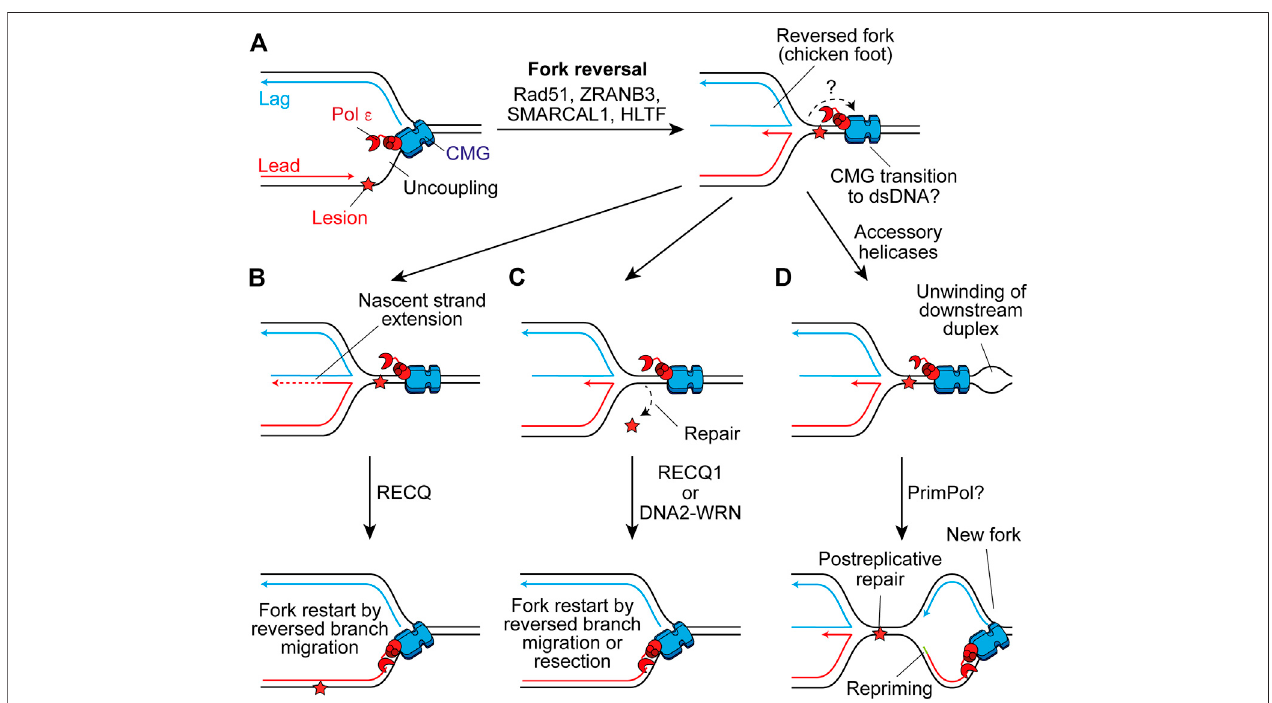
FIGURE6| Forkreversalmaymaintainorrestartreplisomeprogressionpastleading-strandimpediments. (A) Followinguncoupling,forkreversalcanbecatalysed by Rad51, ZRANB3, SMARCAL1, and HLTF to generate a four-way chicken foot structure in a process which is not currently well understood. The fate of CMG here is not clear, one possibility is that it transitions on to duplex DNA downstream of the lesion. (B) The nascent lagging strand could serve as a template for extension of the nascentleadingstrand.Subsequentreversedbranchmigration,catalysedbyRECQ1,maysupportforkrestartiftheextended3 ′ endofthenascentleadingstrand isrelocated downstreamofthe lesion.CMGmay thentransition backonto ssDNAtorestartcanonicalreplication. (C) Alternatively, forkreversal may placethelesion ina dsDNA context to permit repair, before resetting of the fork by RECQ1 or resection of nascent strands by DNA2-WRN. Again, CMG may transition back onto ssDNA to restart rapid fork progression. (D) Another possibility is that accessory helicases unwind the parental duplex downstream of the impediment following fork reversal. This mayallowtheestablishmentofanewreplicationforkwhichwouldrequirereprimingoftheleadingstrand.Thiswouldleavethechickenfootstructurebehindthenewfork to be resolved following postreplicative repair of the